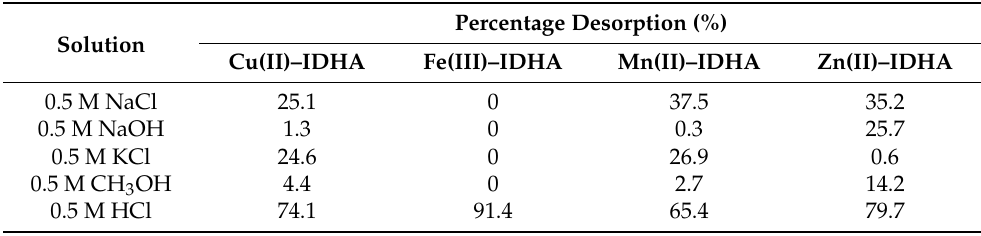
Table 7. Percentage desorption DP(%) of Cu(II), Fe(III), Mn(II), and Zn(II) complexes with IDHA for